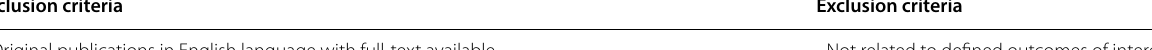
Table 1 Detailed inclusion and exclusion criteria Inclusion